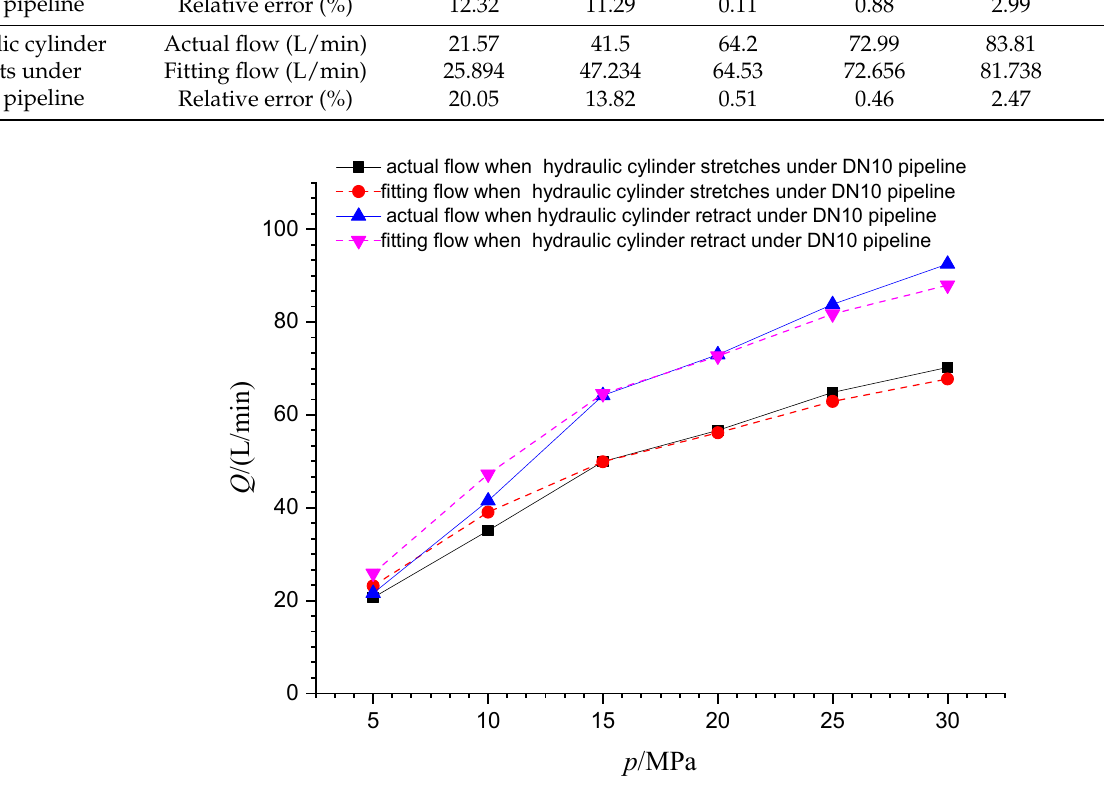
Figure 15. Comparison diagram of fitting flow and actual flow under DN10 diameter pipeline when the hydraulic cylinder extended and retracted.